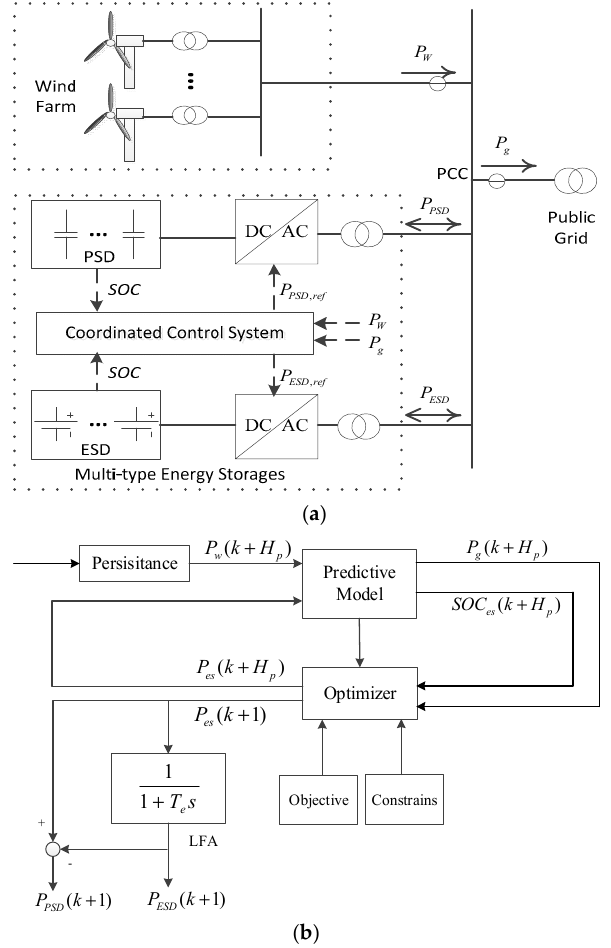
Figure 1. ( a ) Multi-type energy storage for wind power fluctuation smoothing. ( b ) Coordinated control based on MPC. ( H p is MPC predicted horizon).